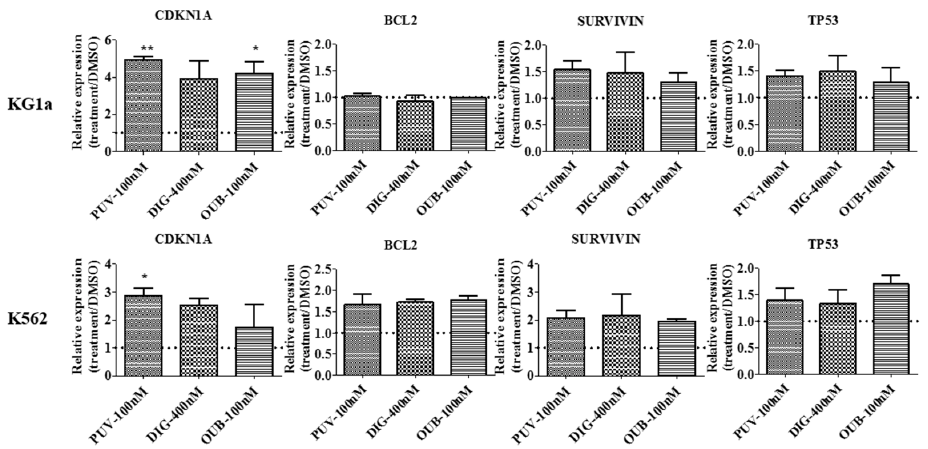
Figure 6. Up-regulation of cyclin-dependent kinase inhibitor 1A in leukemia cells after Peruvoside treatment. KG1a and K562 cells were treated with different CGs for 24 h. RNA was isolated from each sample and cDNA was synthesized for Real-time PCR analyses with gene specific primers using the SYBR green method. Data was normalized to β -actin expression and the relative quantity of gene expression level was calculated by ΔΔ Ct method. Changes in expression are presented as fold change relative to DMSO. Dot line indicates DMSO value set as 1. PUV, Peruvoside; DIG, Digitoxin; OUB, Ouabain. n = 3, *, p < 0.05; **, p < 0.01.